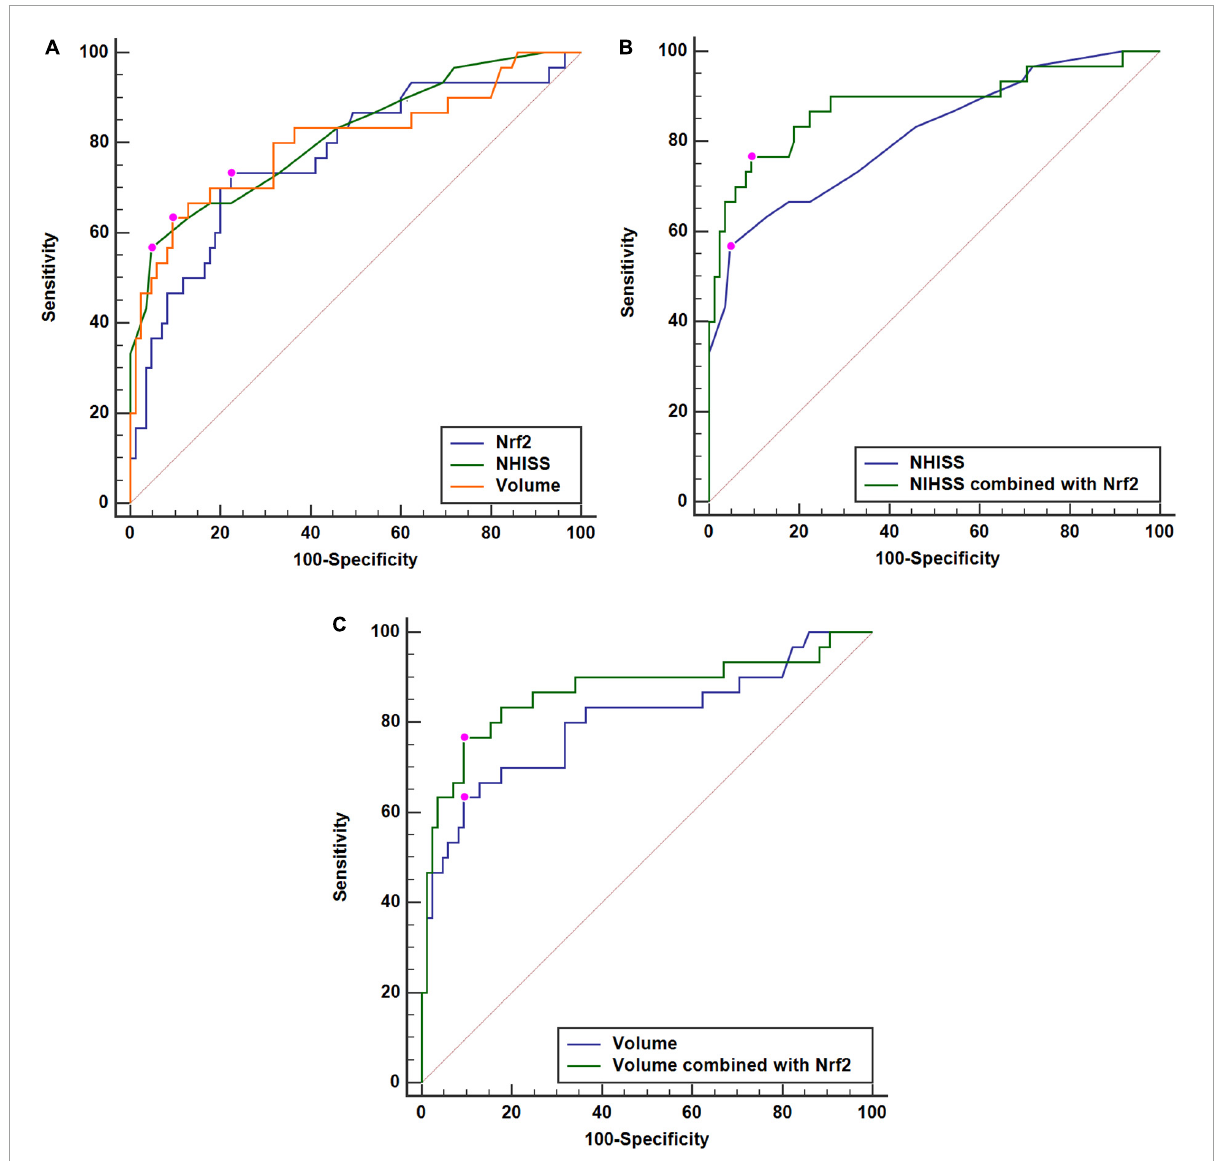
FIGURE5 Comparisons of discriminatory capabilities for early neurologic deterioration (END) among serum nuclear factor erythroid 2-related factor 2 (Nrf2) levels, National Institutes of Health Stroke Scale (NIHSS) scores, and hematoma volume after acute supratentorial intracerebral hemorrhage (ICH). (A) Comparisons of areas under curve for END among serum Nrf2 levels, NIHSS scores, and hematoma volume after acute supratentorial ICH. (B) Comparison of areas under curve for END between serum Nrf2 levels combined with NIHSS scores and NIHSS scores after acute supratentorial ICH. (C) Comparison of areas under curve for END between serum Nrf2 levels combined with hematoma volume and hematoma volume after acute supratentorial ICH. Serum Nrf2 levels had similar area under curve, as compared to NIHSS scores and hematoma volume (both P > 0.05). Moreover, serum Nrf2 levels profoundly improved areas under curve of NIHSS scores and hematoma volume (both P < 0.05). Nrf2 indicates nuclear factor erythroid 2-related factor 2; NIHSS, National Institutes of Health Stroke